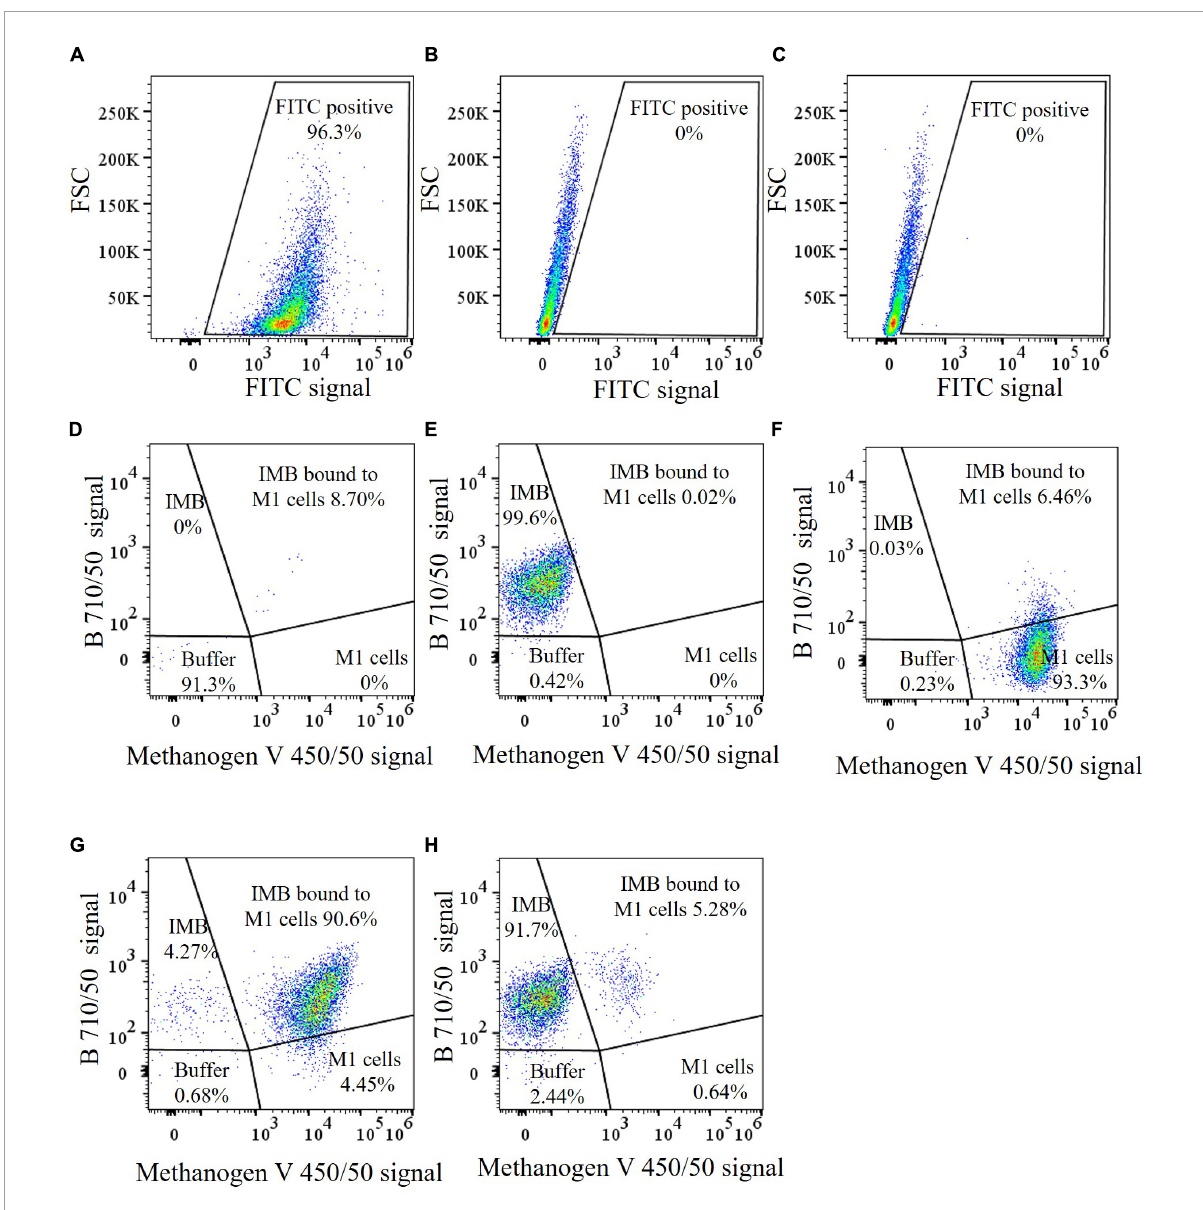
FIGURE1 Flow cytometric analysis of IMBs preparations. (A − C) Coupling of anti-M1 serum antibodies to paramagnetic beads demonstrated using FITC labeled anti-sheep antibodies. A gate was selected for the FITC positive subset. (A) Dot plot of M1-IMBs coated with sheep antibodies were detected with secondary FITC-labeled anti-sheep antibodies, (B) Dot plot of forward scatter (FSC) vs FITC of M1-IMBs, (C) FITC-labeled anti-mouse antibodies were used as a negative control. (D − H) A violet laser was used to detect M. ruminantium M1 cells based on the auto fluorescence of methanogen coenzyme F 420 . IMBs were detected by the B710/50 detector. Gates were selected based on the position of individual sample components when analyzed separately. (D) Dot plot of B 710/50 vs methanogen V 450/50 of buffer only control, (E) IMBs only control, (F) M. ruminantium M1 cells, (G) M1-IMBs were incubated with M1 cells and analyzed after washing, M1 cells bound to M1-IMBs were clearly seen as a shift on the X-axis, (H) NC-IMBs were incubated with M1 cells and analyzed after washing. The sectors of the plots are labeled with the expected locations of different combinations of buffer particles, IMBs and methanogens, and the percentage values are the particle counts in that sector.